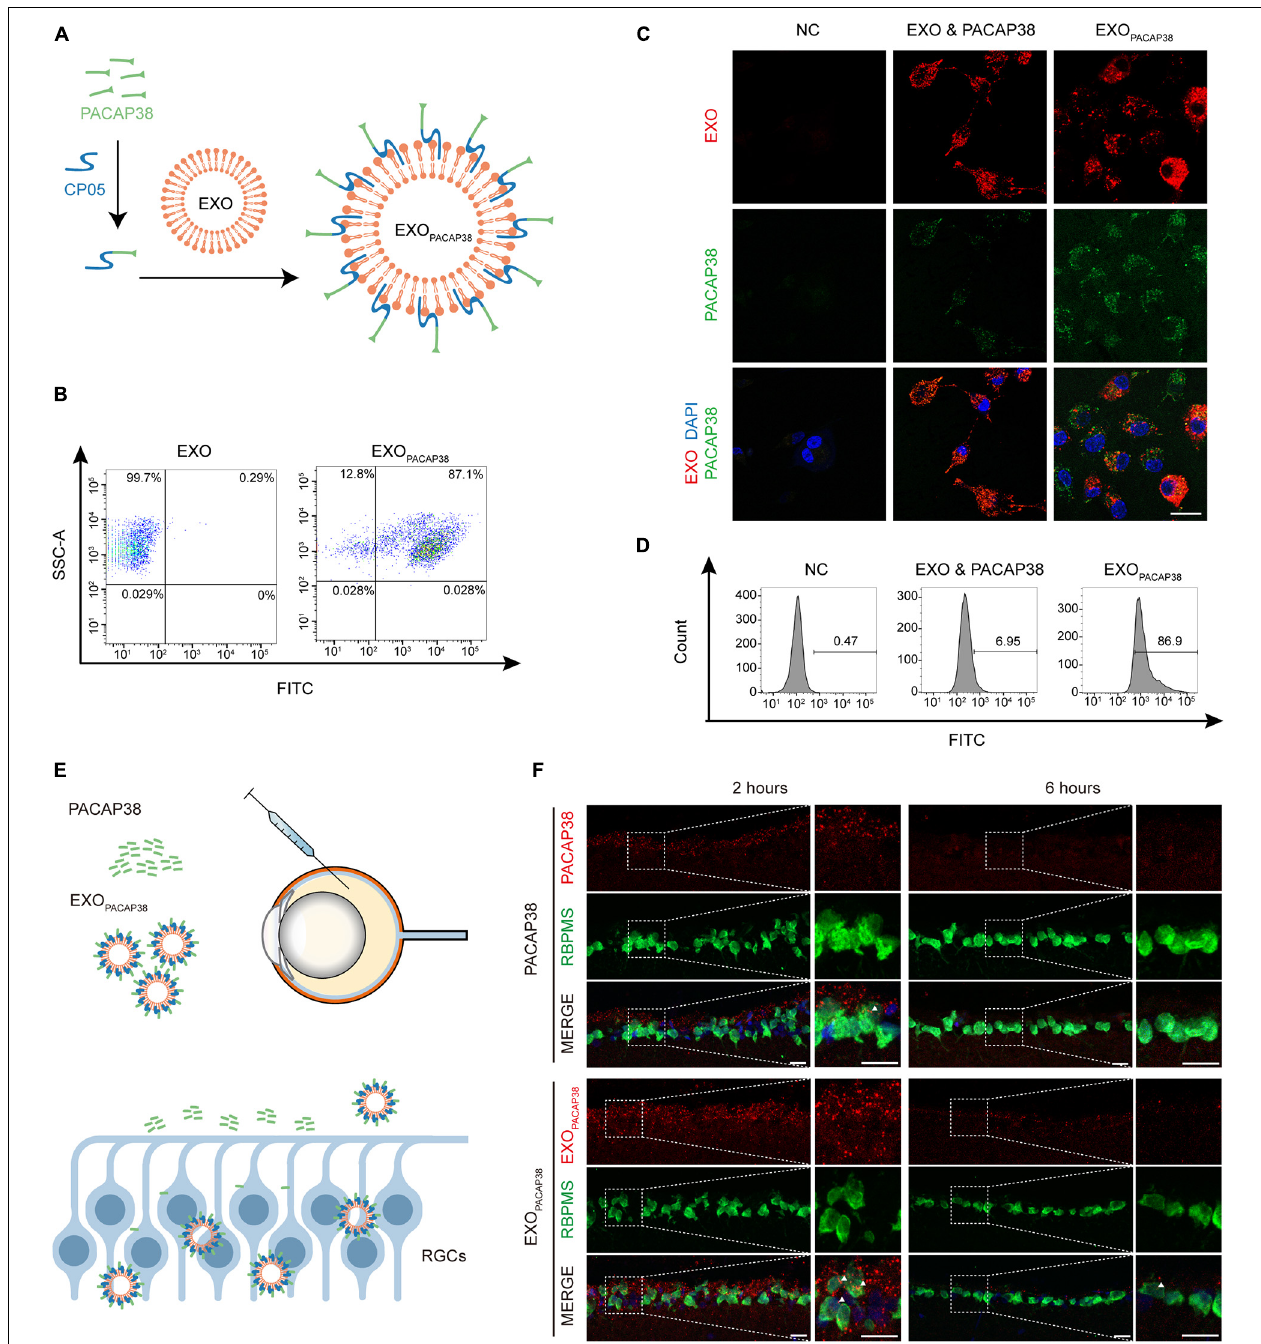
FIGURE 1 | Efficient uptake of EXO PACAP 38 in vitro and in vivo . (A) Scheme of preparing the PACAP38 delivery system, EXO PACAP 38 . (B) Results of FACS assessing the binding efficiency of PACAP38 on EXOs via the exosome anchor peptide CP05. CP05 and PACAP38 form the chimera CP05-PACAP38 through a chemical method in vitro , and CP05-PACAP38 was labeled with FITC. (C) Representative fluorescence microscopic images showing the uptake of PACAP38 in RGCs. PACAP38 and CP05-PACAP38 were labeled with FITC, and the EXOs were labeled with DiR (scale bar = 20 µ m). (D) Results of flow cytometry measuring the cellular uptake efficiency in RGCs in each group. (E) Scheme of PACAP38 and EXO PACAP 38 delivery after intravitreal injection. (F) Representative images of retinal sections showing the delivery efficiency of PACAP38 and EXO PACAP 38 . The retinal sections are from animals at 2 and 6 h after injection, and counterstained with RBPMS (green) and DAPI (blue) (scale bar = 20 µ m) (NC: normal control).